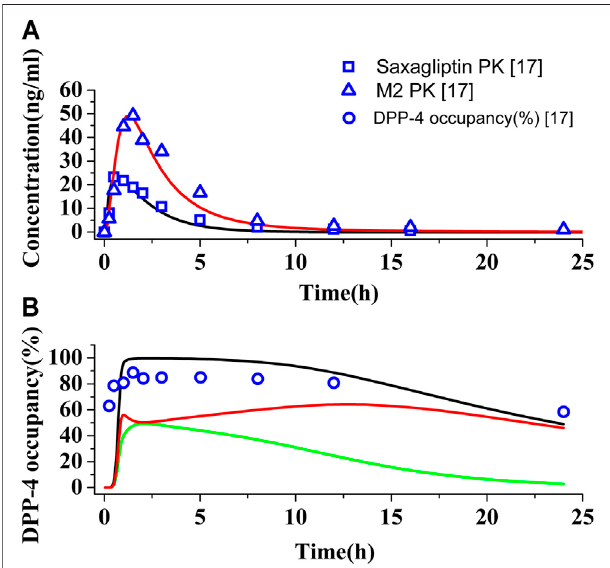
FIGURE2| Simulations of pharmacokinetics and DPP-4 occupancy in humans. (A) Predicted and observed human plasma concentration – time curves of saxagliptin and M2 after oral administration at a dose of 5 mg. Black ( ∩ ) and red ( ∩ ) solid lines represent plasma concentration – time curves of saxagliptin and M2, respectively. The blue squares (.) and blue up- triangles ( △ ) refer to experimentally measured pharmacokinetic data of saxagliptin and M2, respectively. (B) Predicted and observed timecourse of DPP-4 occupancy by saxagliptin in humans following oral administration of 5 mg. Black ( ∩ ), green ( ∩ ), and red ( ∩ ) solid lines represent human DPP-4 occupancy curves of saxagliptin + M2, saxagliptin, and M2, respectively. The blue circles ( ˆ x) refer to experimentally measured DPP-4 occupancy